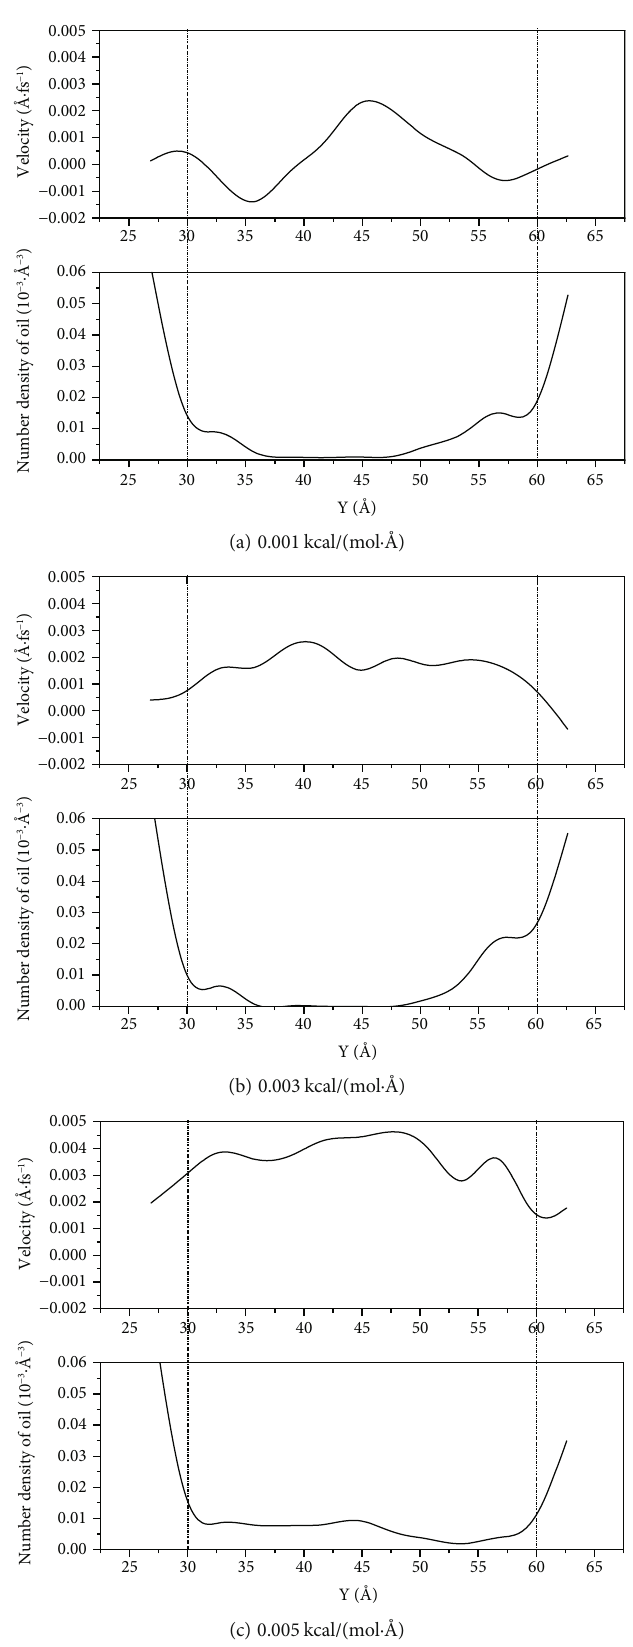
Figure 14: The fl ow velocity and density distribution of oil under di ff erent driving forces in the Y direction at